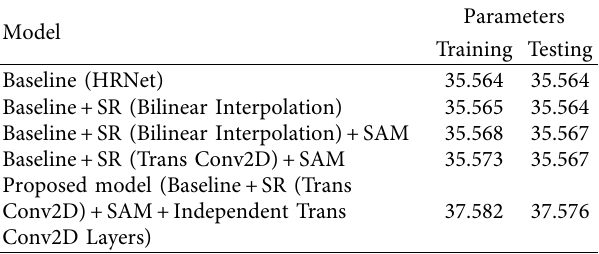
Figure 8: Comparison on the feature maps generated by the Independent Trans Conv2D layers and bilinear Table 4: Parameter comparison in ablation models during training and testing ( M ).